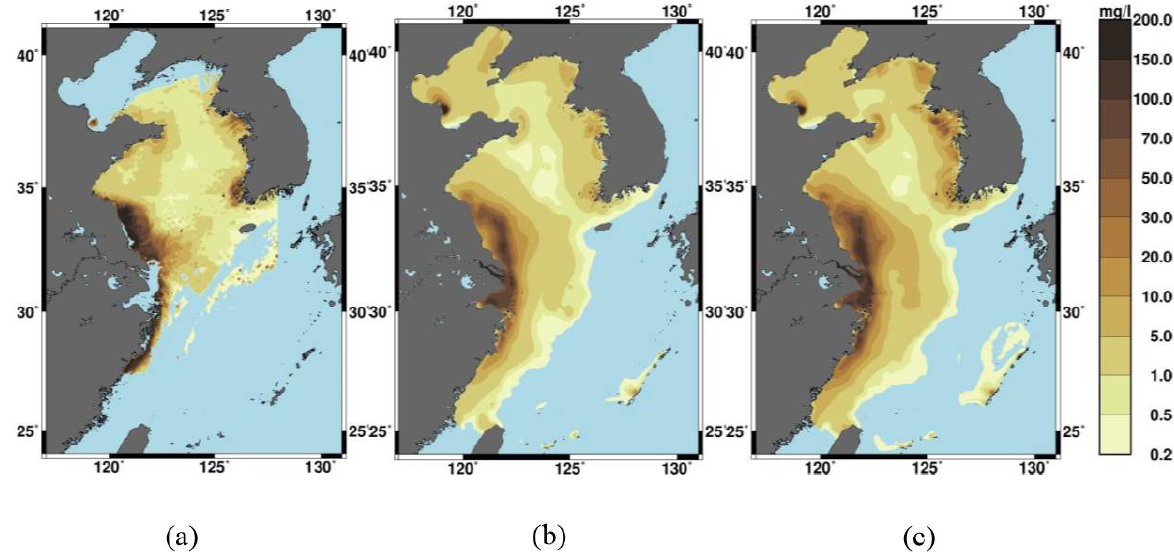
Figure 10. Surface distribution of SSC from ( a ) GOCI remote sensing data; ( b ) simulation without waves; ( c ) simulation with waves for 4 October 2013.